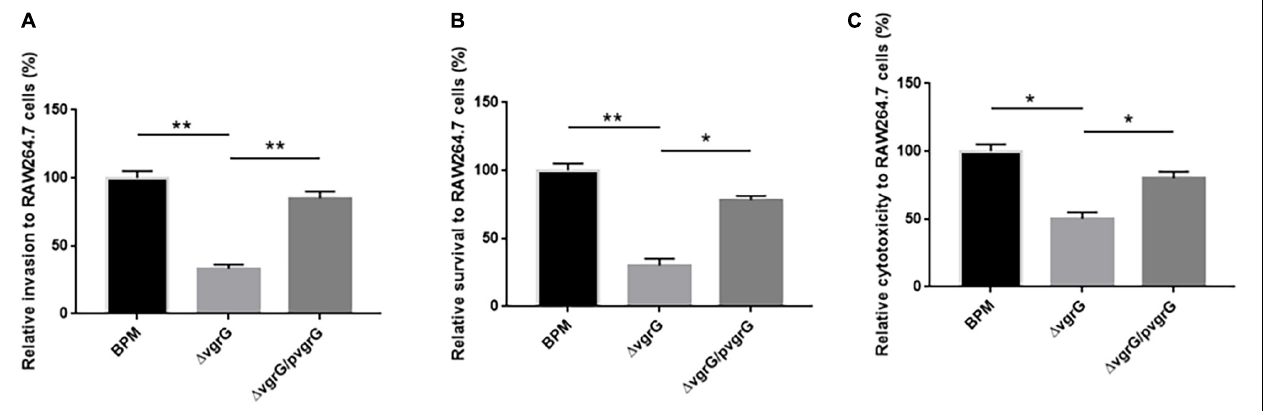
FIGURE 6 | Interaction between bacteria and RAW264.7 cells. (A–C) indicate the invasion ability, intracellular survival ability, and the cytotoxicity, respectively, of the BPM, mutant and complemented strains in RAW264.7 cells. Rates of invasion, survival and cytotoxicity are expressed relative to those of BPM (100%). The means and SDs of three independent experiments in conducted triplicate were calculated. Significant differences between groups are indicated: *( P < 0.05) and **( P < 0.01).